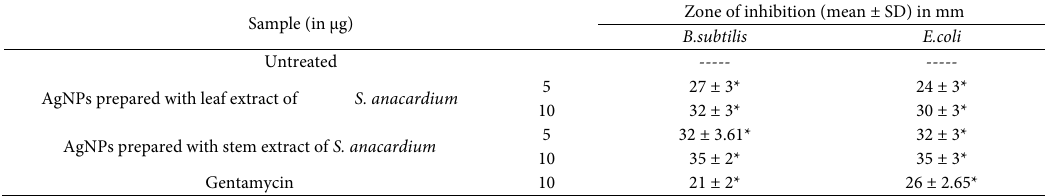
Table 1. Zone of inhibition values for AgNPs prepared using leaf and stem extracts of L.